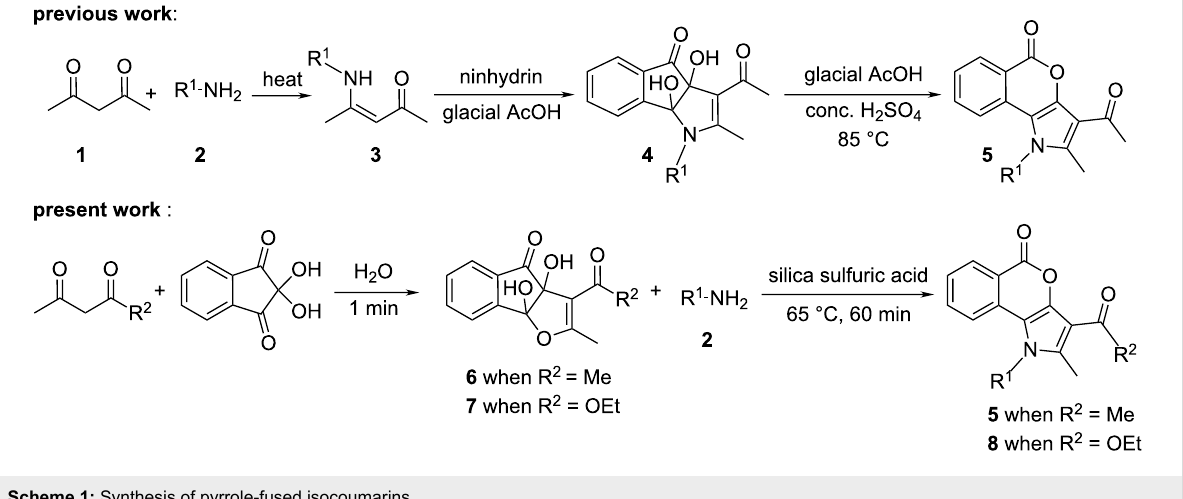
Scheme 1: Synthesis of pyrrole-fused